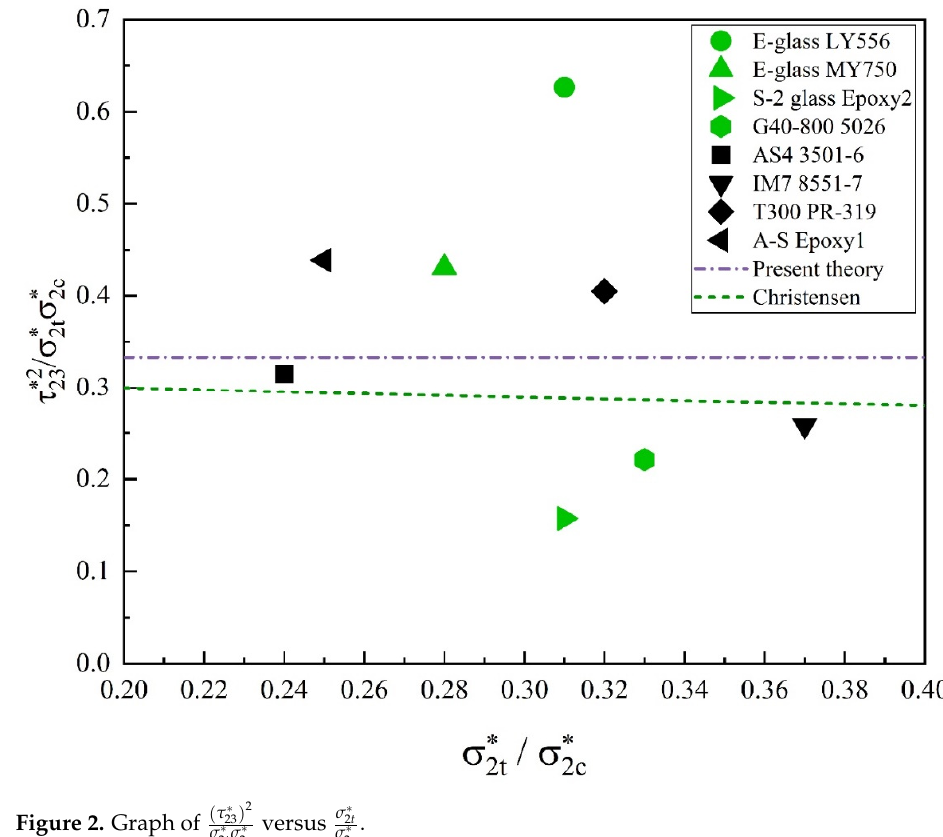
Figure 2. Graph of